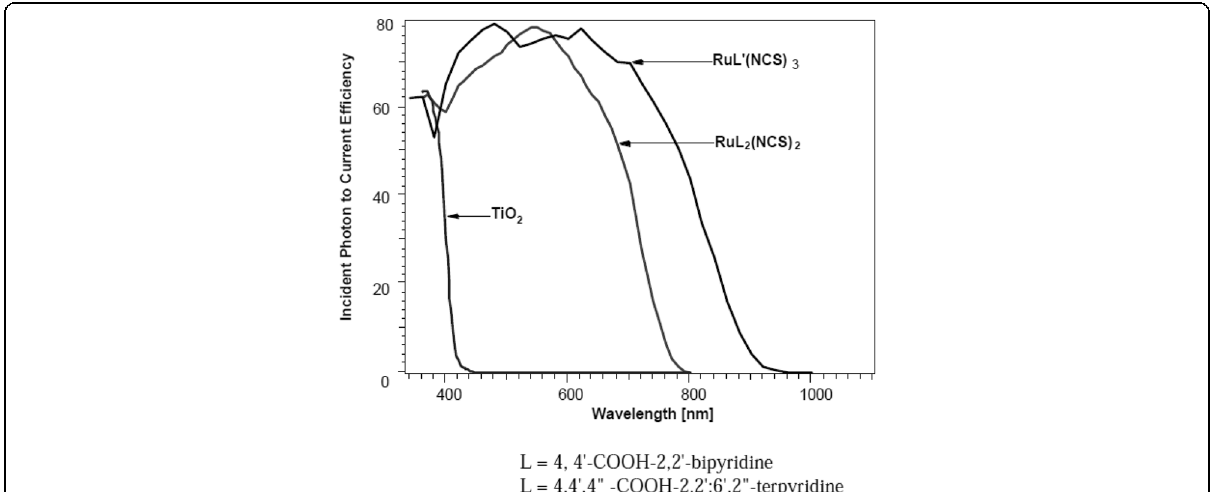
Fig. 15 Photocurrent action spectra obtained with the N3 (ligand L) and the black dye (ligand L_) as sensitizer. The photocurrent response of bare TiO 2 films is also shown for comparison